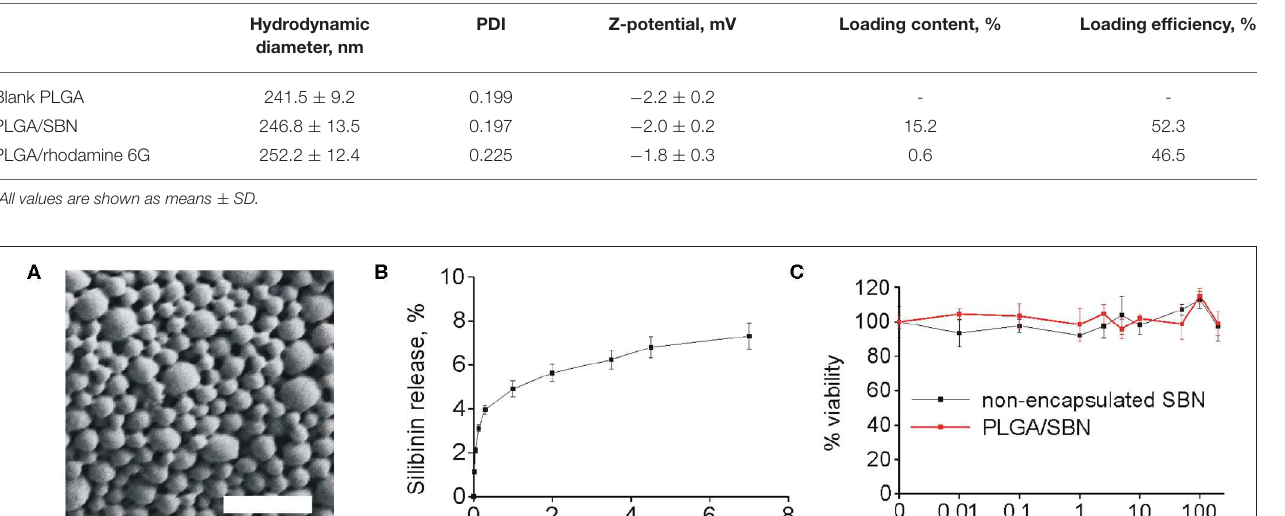
TABLE 1 | Characterization of PLGA nanoparticle formulations * .